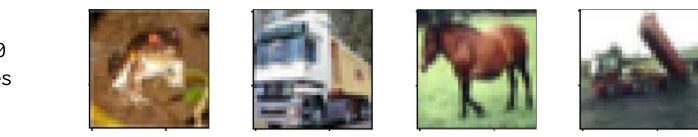
Figure 10. Some samples of the CIFAR-10 dataset.